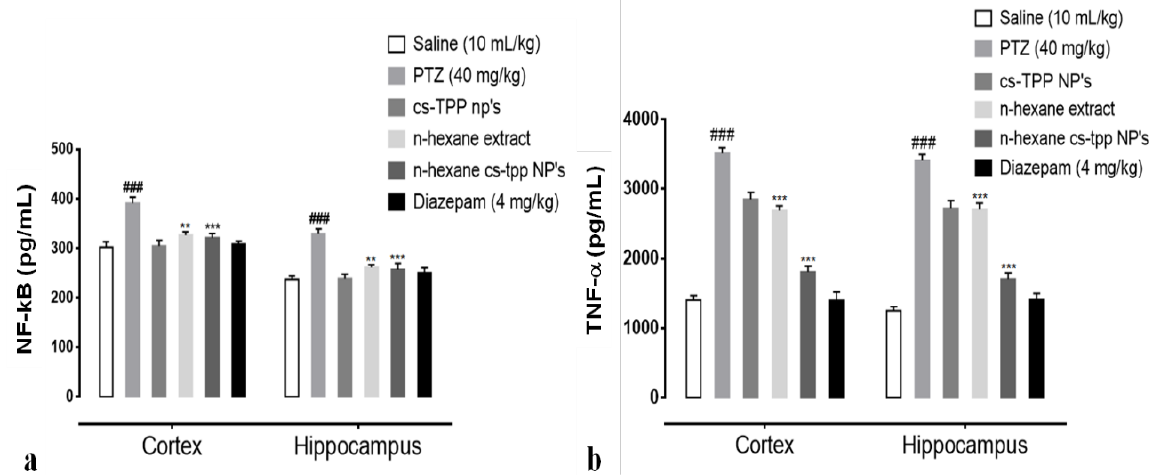
Figure 8. ( a ) Illustrates the effect of Rosa webbiana on the downregulated expression of p-NF-κB in the cortex and hippocampus of all treated rats; symbol ### symbolizes the significant difference from saline at p < 0.001, while symbols ** and *** indicate significant difference from PTZ at p < 0.01 and p < 0.001, respectively. ( b ) Effect of Rosa webbiana on TNF-α expression in the cortex and hippocampus of all treated rats; symbols. ### symbolizes the significant difference from saline at p < 0.001, while symbols ** and *** indicate a significant difference from PTZ at p < 0.01 and p < 0.001.